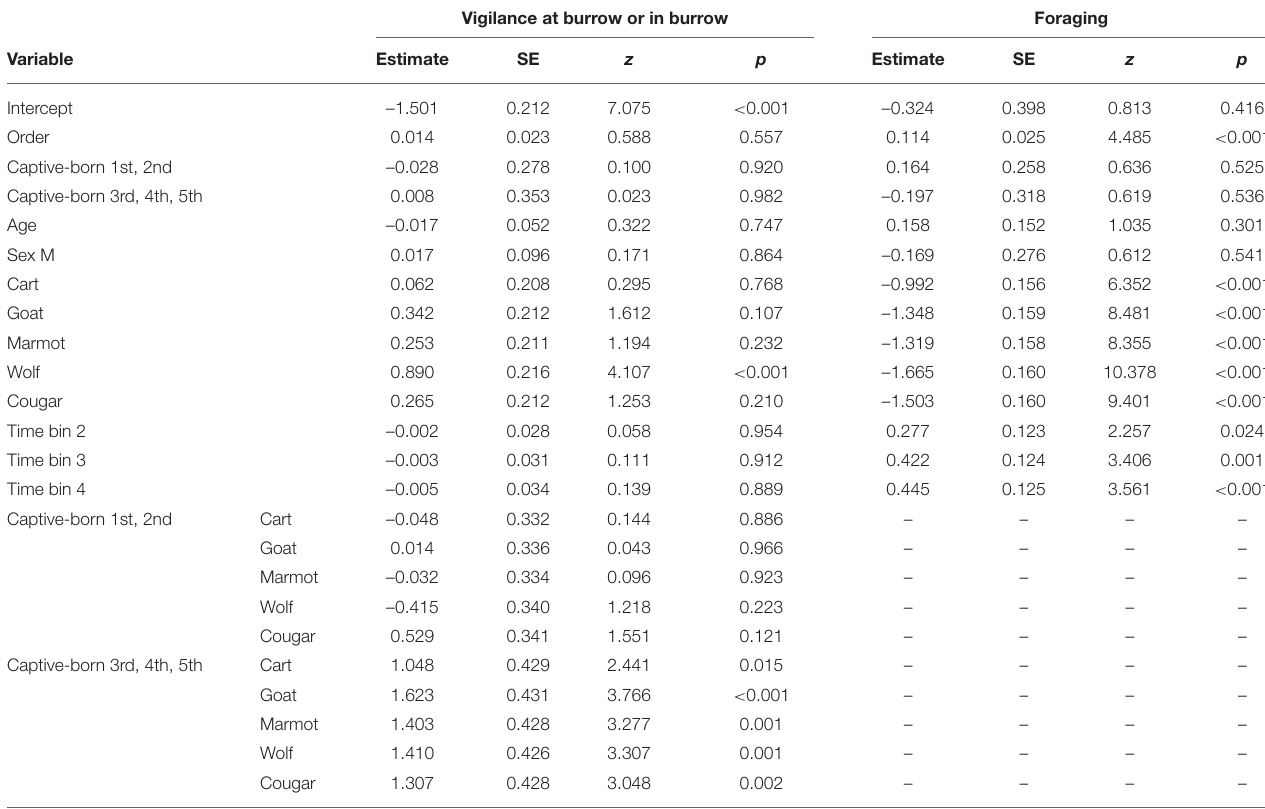
TABLE 3 | Model average mixed-effects models for the proportion of time Vancouver Island marmots ( n = 34) allocated to behaviors of interest in response to taxidermy mounts of mammals, as well as an empty cart and a blank, where no stimulus was